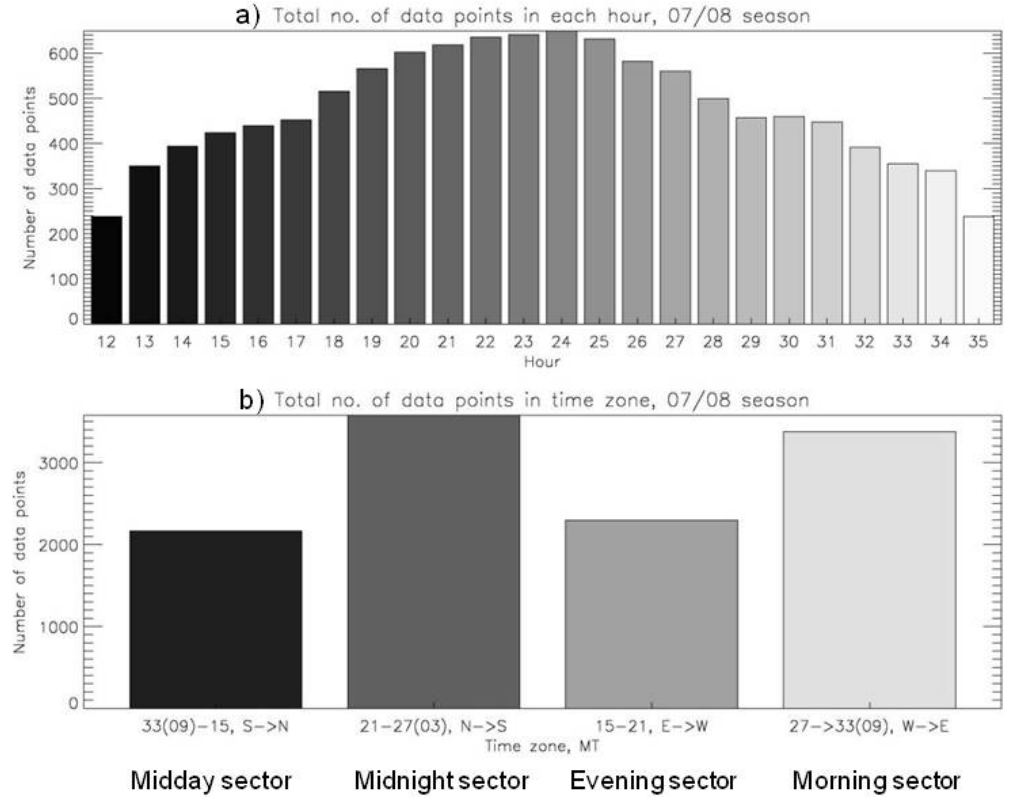
Fig. 5. Frequency distribution of data points during the winter of 2007–2008.